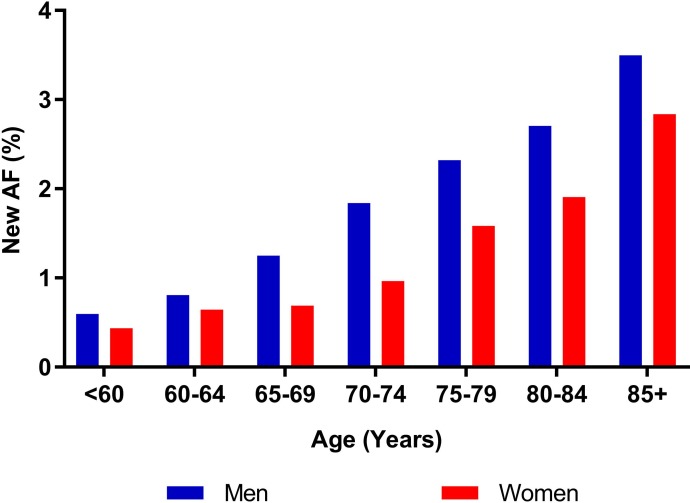
AF pooled yield by sex.AF, atrial fibrillation.